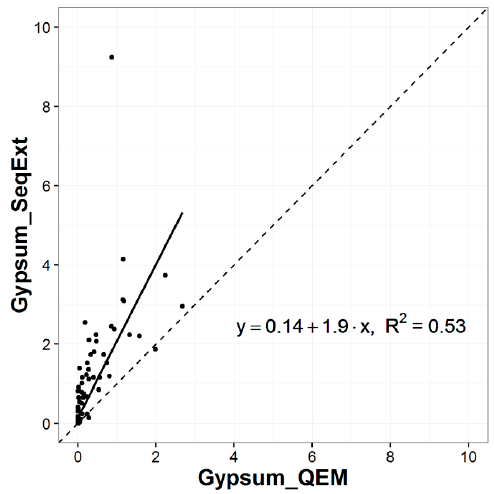
Figure 3. Scatter plot for percentages of gypsum calculated from sequential extraction results versus those detected by QEMSCAN ® analyses for 2008 study. The dotted line represents the 1:1 correlation line, whereas the solid line is the regression fit.